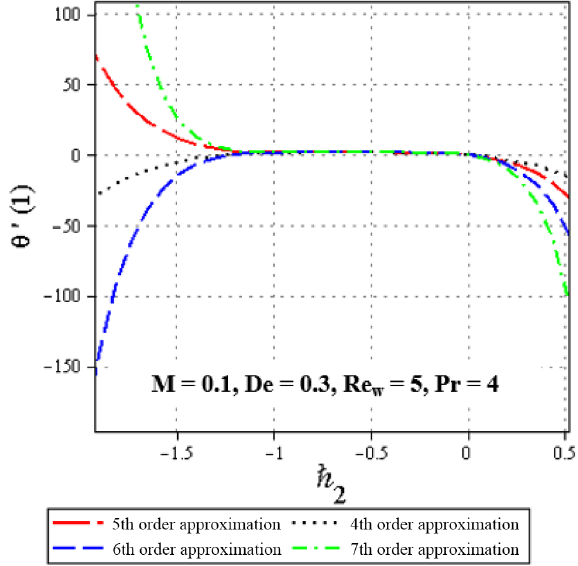
Figure 4. The (cid:125) 2 – validity for M = 0, De = 0.3, Re w = 5 and Pr = 4 given by the 4, 5, 6 and 7th-order